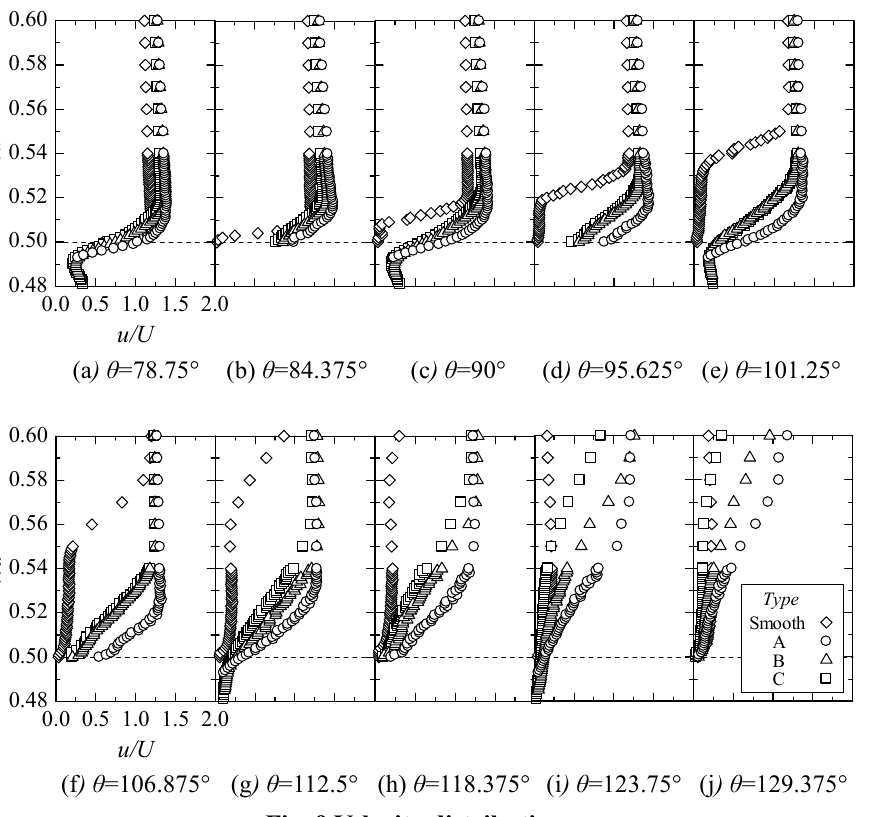
Fig. 9 Velocity distributions